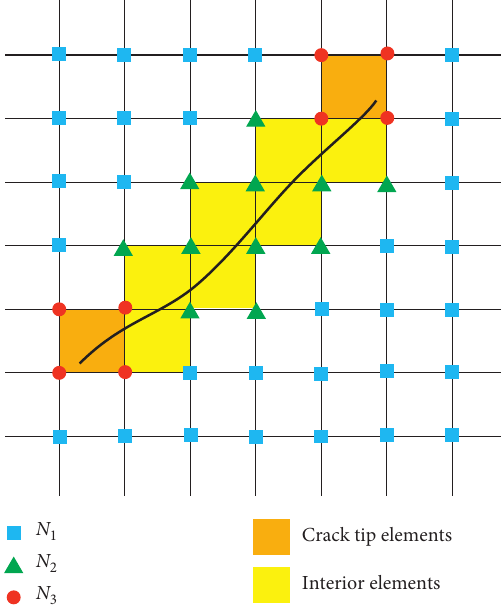
Figure 13: Node and element near